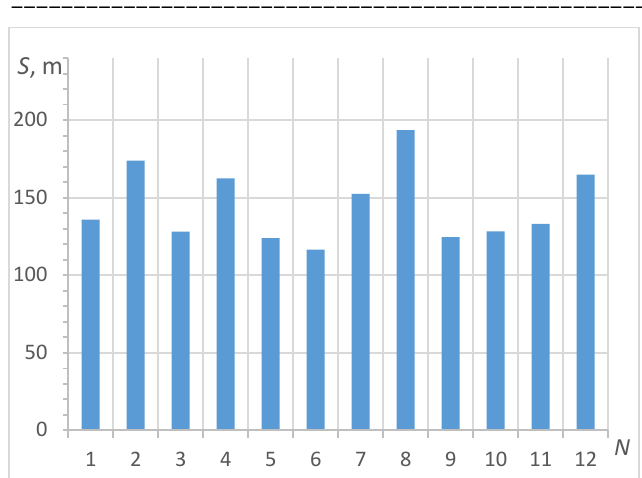
Fig. 12. The altitude at which the optimisation algorithm finds the optimal power consumption.